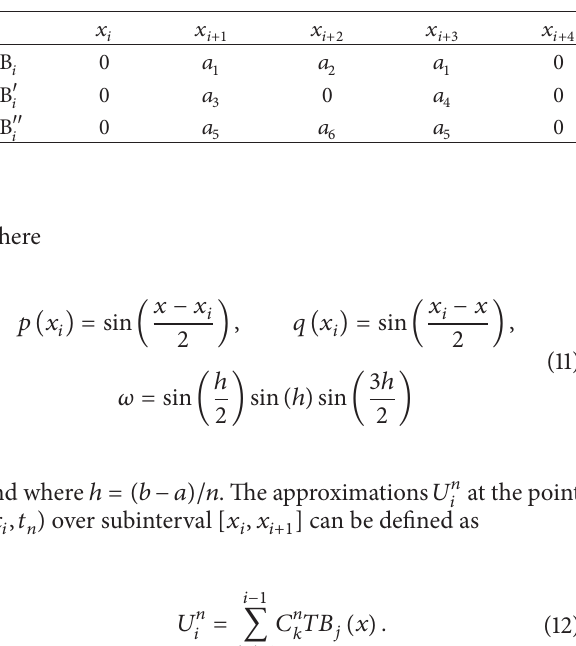
Table 1: Values TB 𝑖 (𝑥) and its